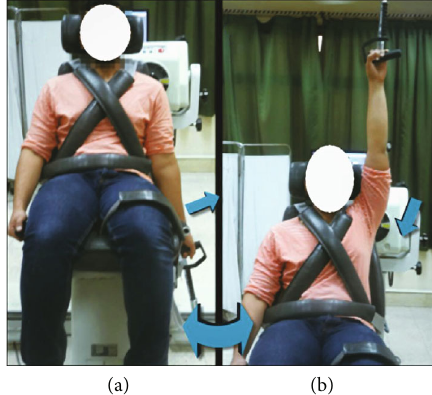
Figure 4: Shoulder fl exor and extensor isokinetic testing: (a) initial position and (b) fi nal